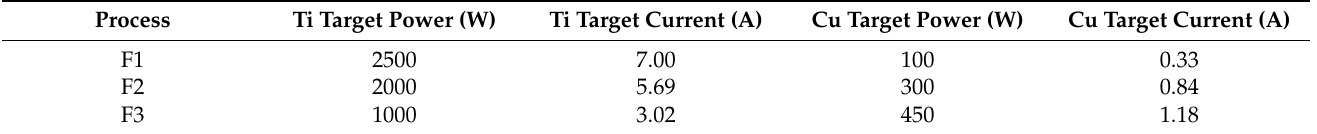
Table 3. The parameters for the fabricated films with different Cu, Ti contents.